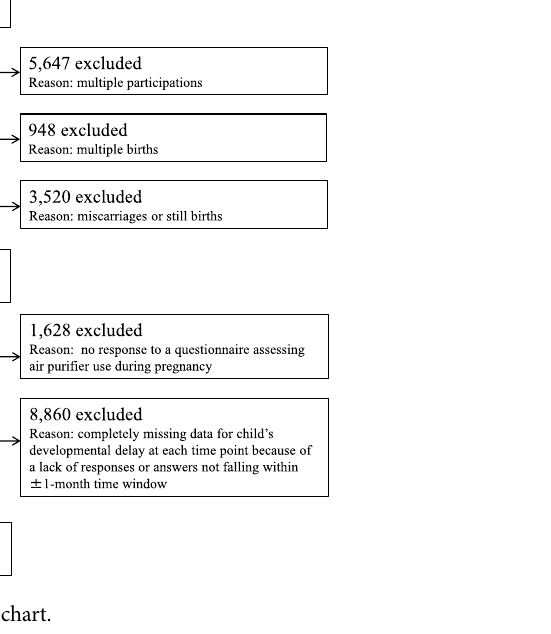
Figure 1. Participants’ flow